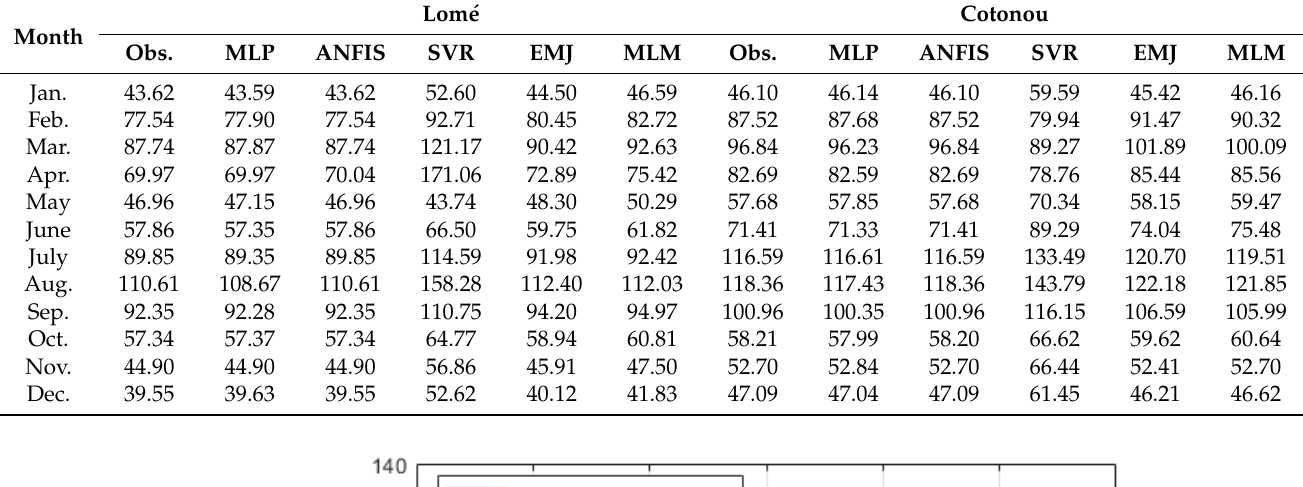
Table 11. Available energy density estimation (kWh/m 2 ) .